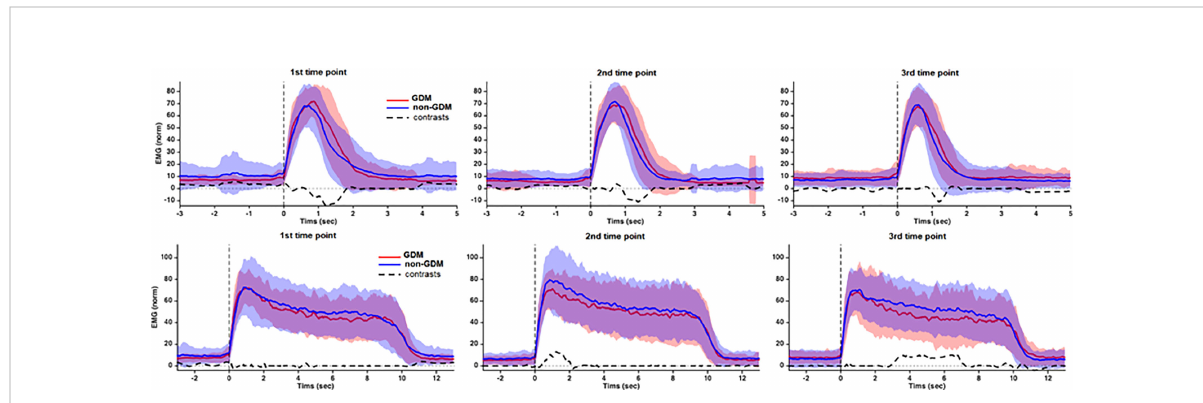
FIGURE 4 Group average and SD of the RMS EMG during the 1-sec Flick and 10-sec Hold PFM contraction tasks from Glazer protocol. Before averaging, the EMG patterns from each subject was expressed as percentage of the peak recorded during the 1-sec Flick contractions. Positive contrasts indicate that GDM < non-GDM. Source: Diamater Study